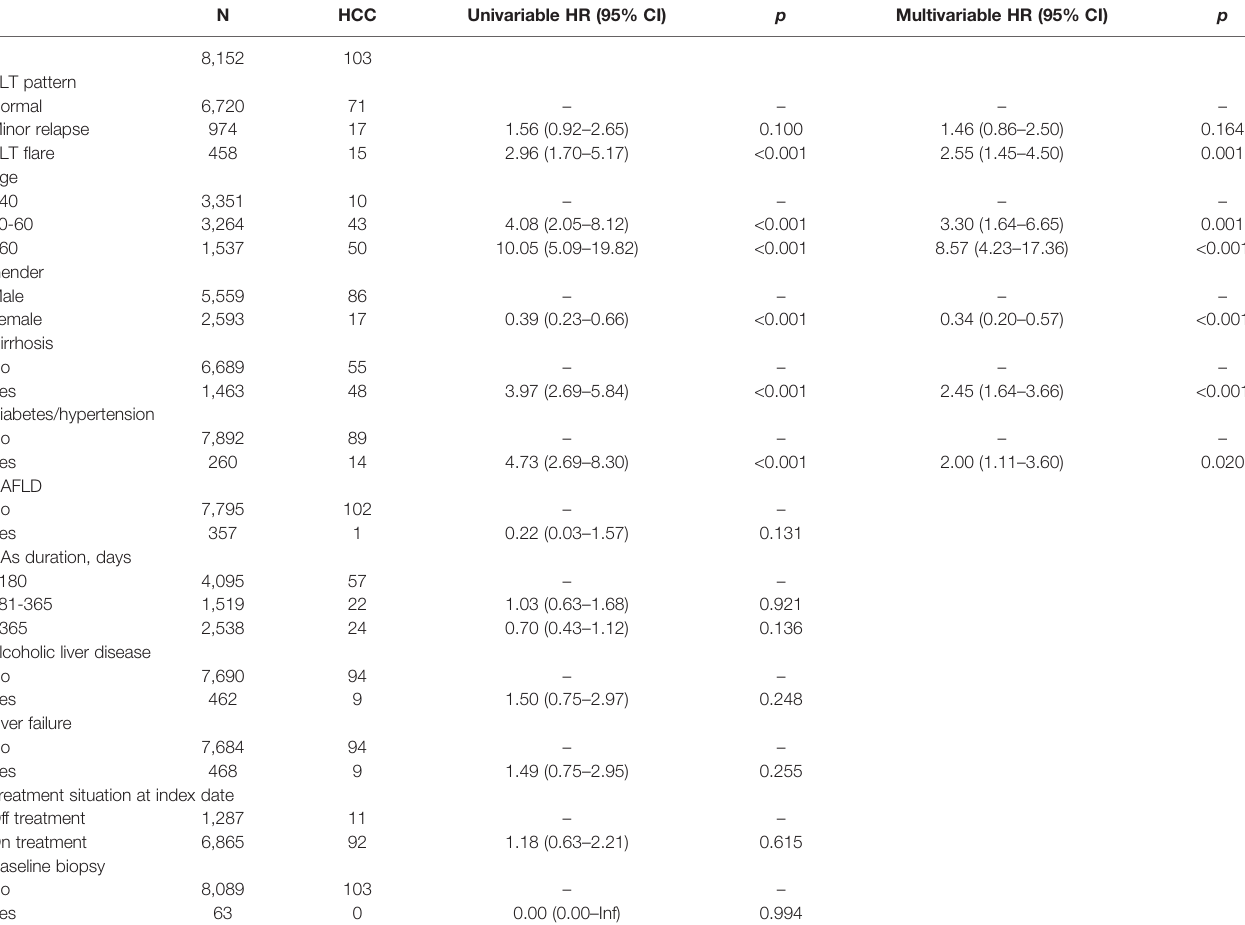
TABLE 3 | Cox proportional hazard model of the association between ALT fl are and hepatocellular carcinoma in China cohort.